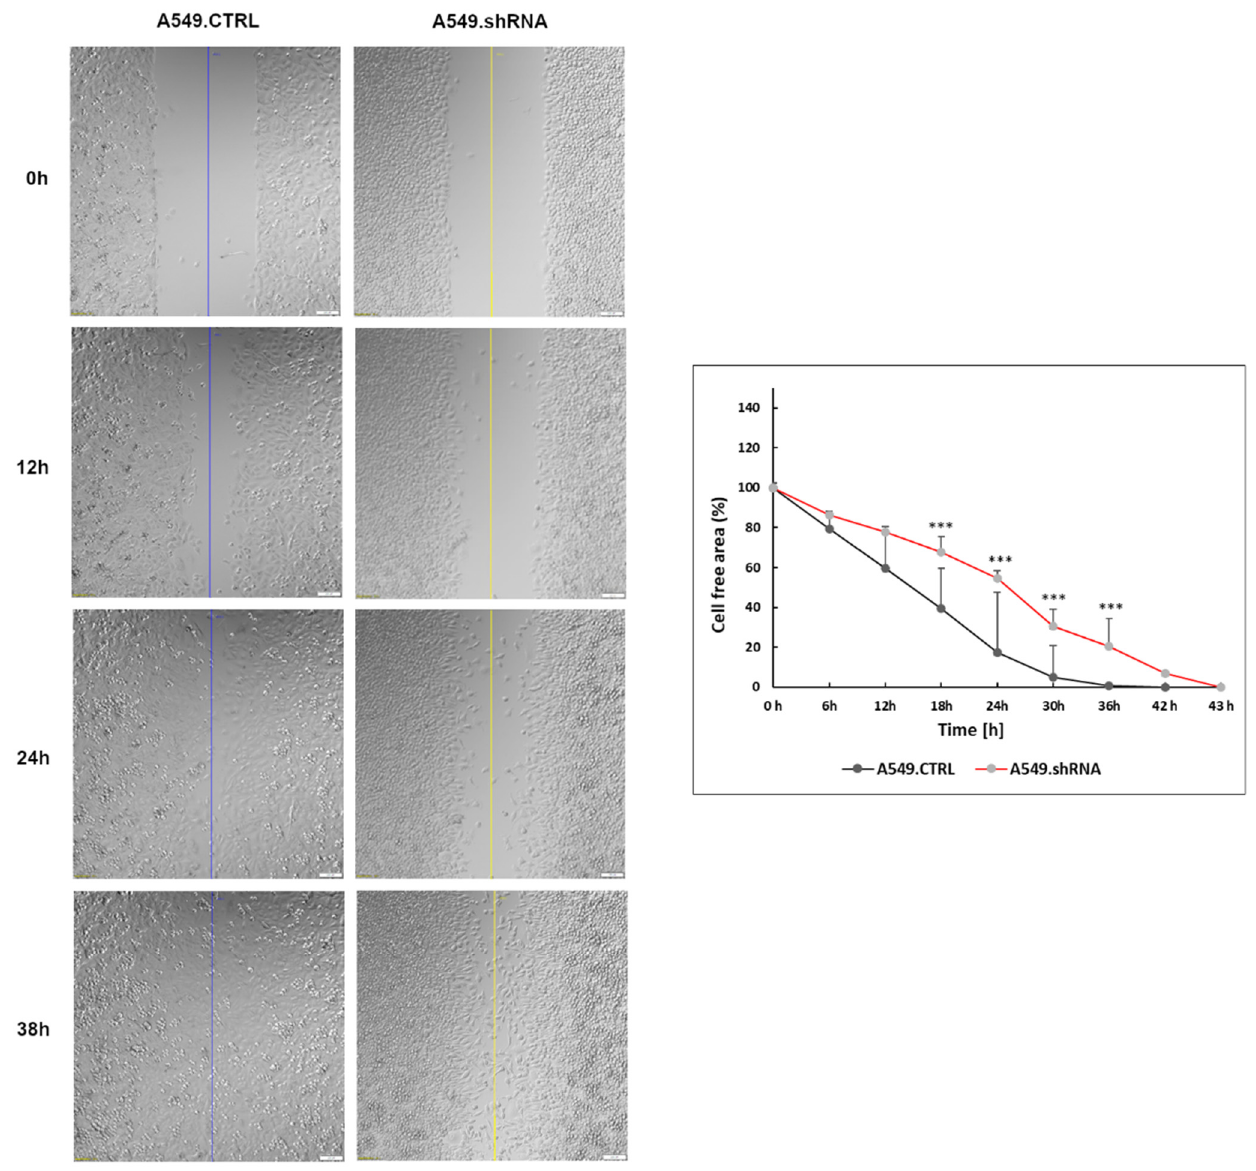
Figure 9. The effect of periostin (POSTN) silencing on the migration of lung cancer cells. Compared to control cells (A549.CTRL), migration of A549.shRNA cells was identified by wound-healing assays. Images were obtained each hour up to 43 h following the injury, always from the same place (3 pictures per well), and analyzed using CellSense software (Olympus, Hamburg, Germany, RRID: SCR_016238). The cell-free area (%) was calculated. Data were analyzed using Bonferroni multiple comparison tests (*** p < 0.001). Magnification 10×. Bar = 100 µm.